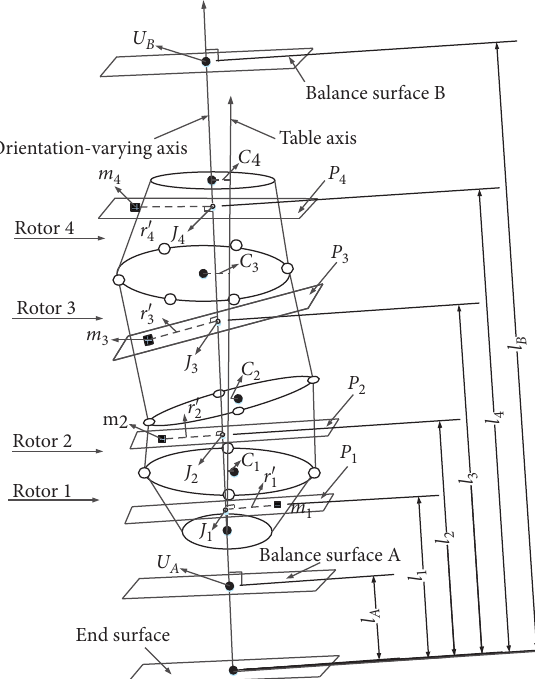
Figure 3: The assembly optimization datum of a four-stage rotor.